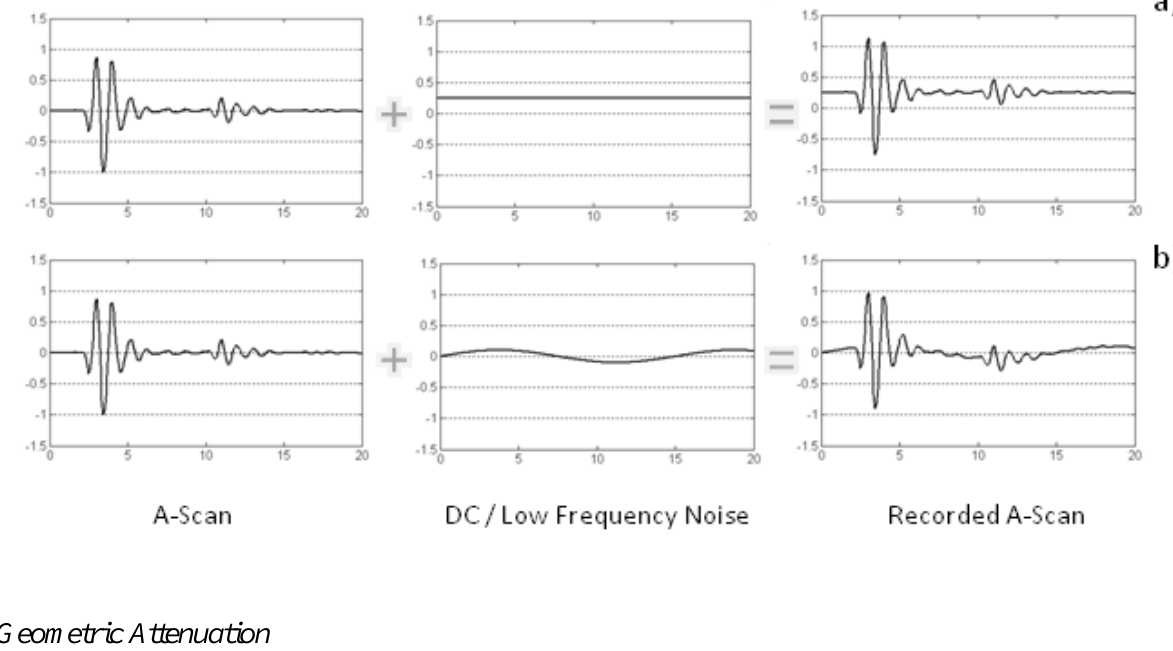
Figure 2. Superposition of a continuous or low frequency component (DC) to the radar signal. This component can be constant (a) or variable (b) along the